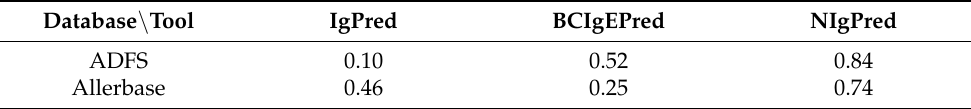
Table 6. Different database accuracies of IgE models when comparing tools. Database \